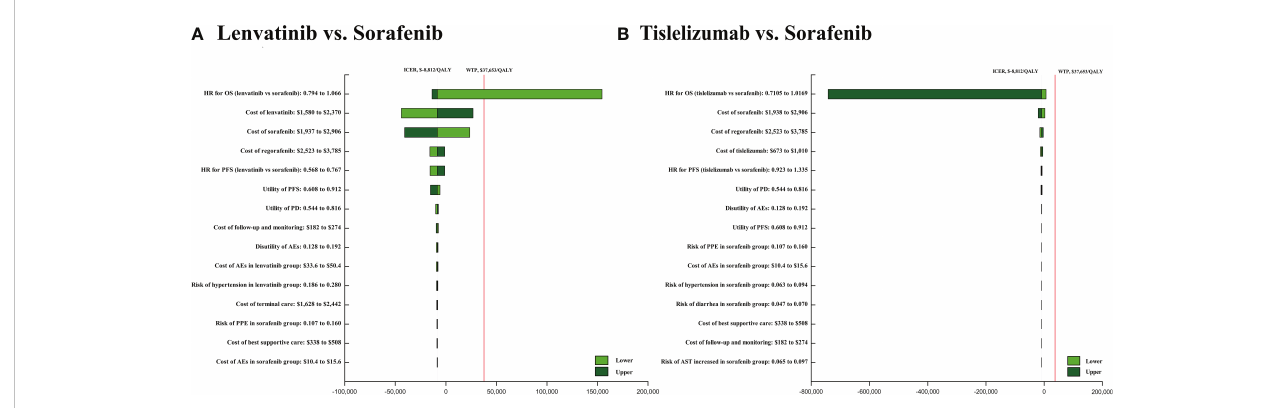
FIGURE 3 The one-way sensitivity analyses of lenvatinib vs sorafenib (A) , tislelizumab vs. sorafenib (B) . PFS, progression-free survival; PD, disease progressed; AEs, adverse events.